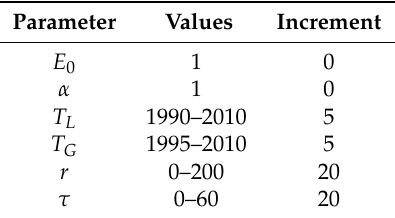
Table 3. Initial values and phase space search increments for the exceedance model parameters of Equation